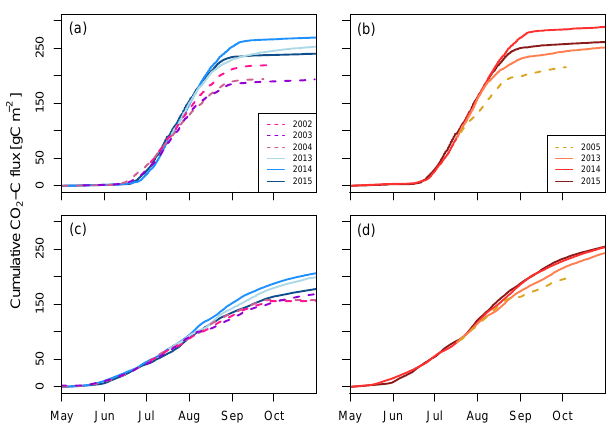
Figure 8. Cumulative signal of recent (2013–2015) and historic (2002–2005) gross primary production (GPP, top panel a and b ) and ecosystem respiration ( R eco , lower panel c and d ), separated into disturbance regimes: (a) and (c) control area; (b) and (d) drained area. Time axes within this plotting scheme are identical to those used in Fig.